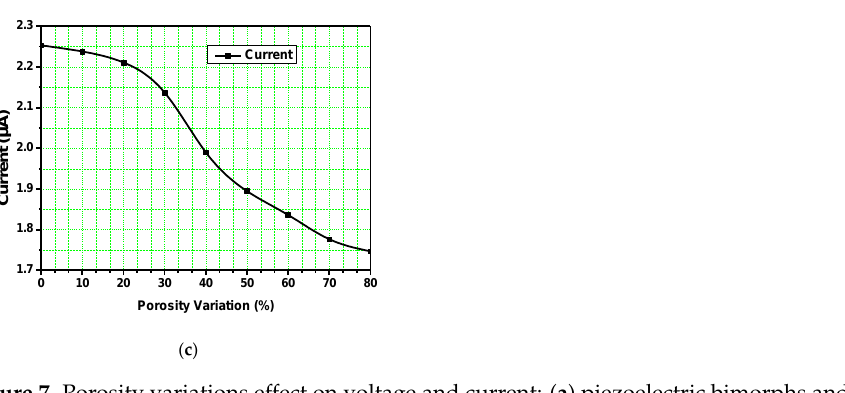
Figure 9. Effect of position of proof mass and porosities. 5.4. Effect of Load Resistance The effect of the load resistance is analysed, when the proof mass is attached at 250 mm distance from piezo cylinder end. The first eigen-value remains the same and total output voltage increases when the resistance increases as shown in Figure 10. The effect of the various porosities at different resistances is analysed. When porosity increases, the